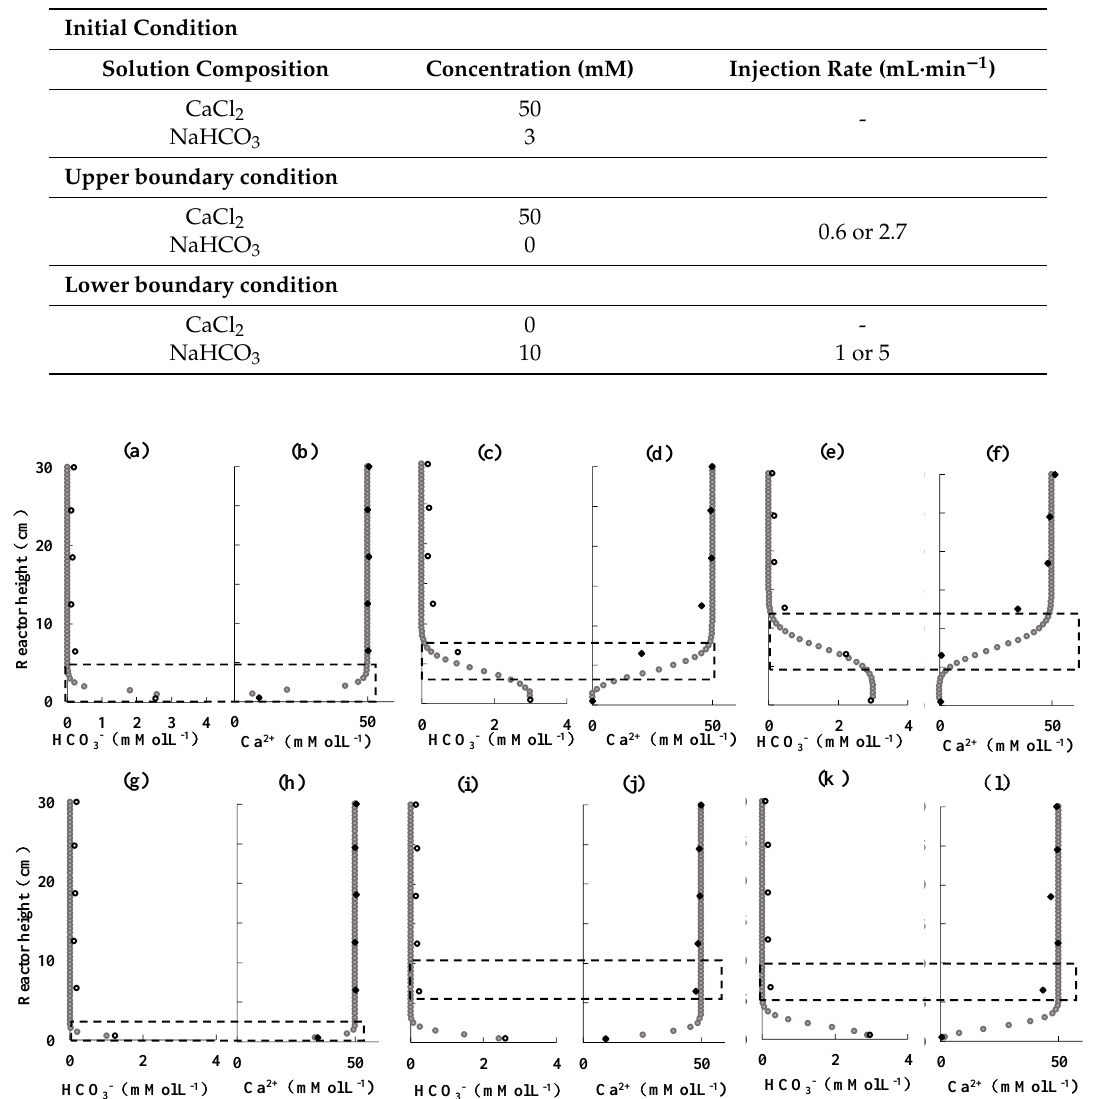
Table 3. Initial conditions and upper and lower boundary conditions.